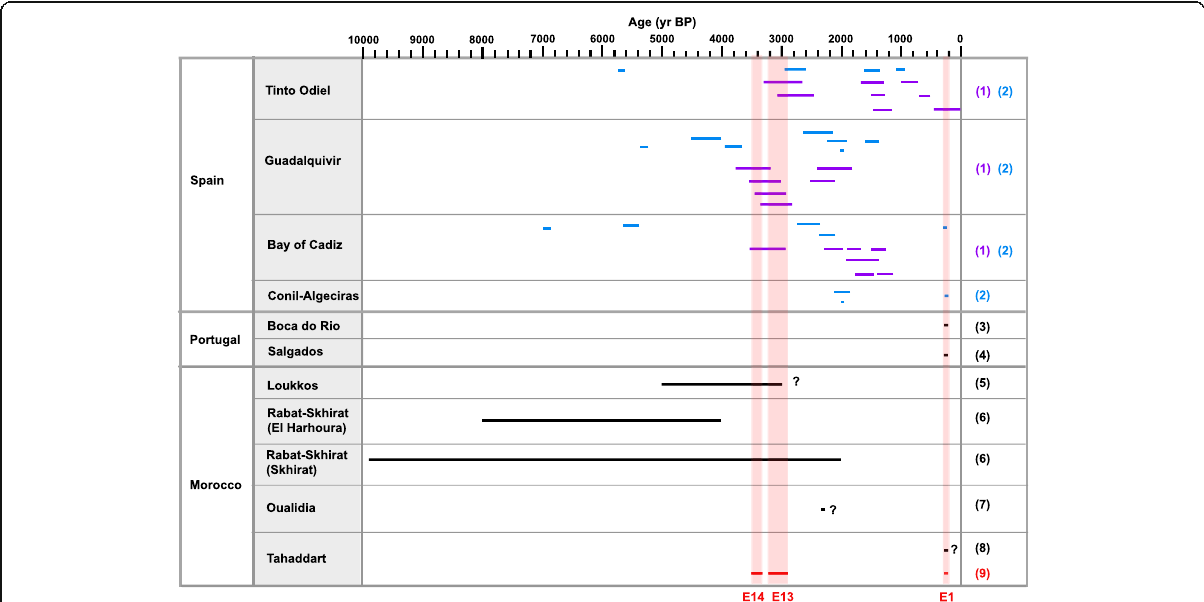
Fig. 6 Chronological correlation of dated events in TAH17 – 1 core with other on-shore deposits along the Atlantic coast of Spain, Portugal and Morocco. (1) Tsunamigenic deposits summarised by Ruiz et al. (2013). (2) Tsunamigenic deposits summarised by Lario et al. (2011). (3) (Dawson et al. 1995) (4) (Costa et al. 2012). (5) (Mhammdi et al. 2015). (6) (Chahid et al. 2016). (7) (Mellas 2012). (8) (El Talibi et al. 2016). (9) This study (Khalfaoui et al.,). The question marks indicate an estimated